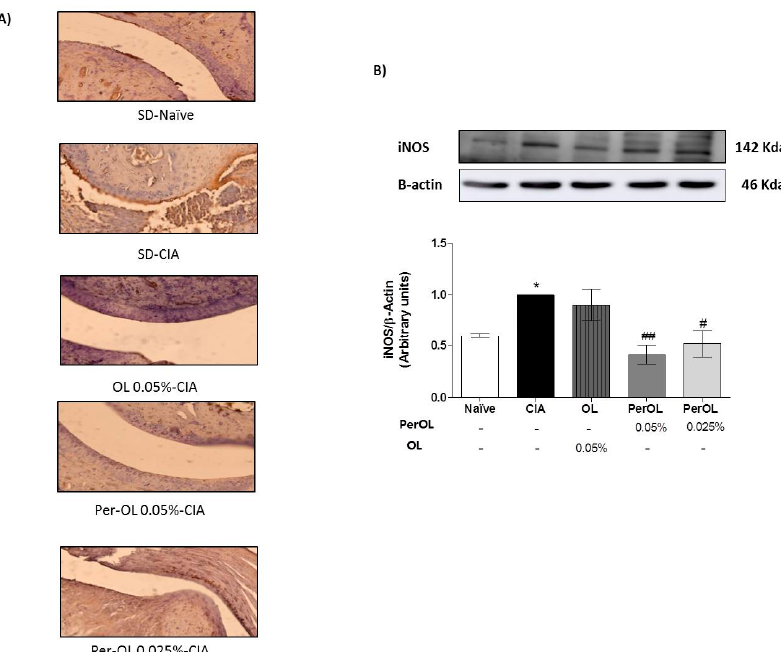
Figure 4. Expressions of COX-2 ( A ) and iNOS ( B ) in hind paws. iNOS protein expression was determined by Western Blot, quantified by densitometry analysis and normalized with respect to a house-keeping β -actin. COX-2 expression was determined by immunohistochemistry. Data represent mean ± S.E.M., n = 5. * p < 0.05 vs. SD-CIA control group; # p < 0.05 and ## p < 0.01 vs. SD-CIA control